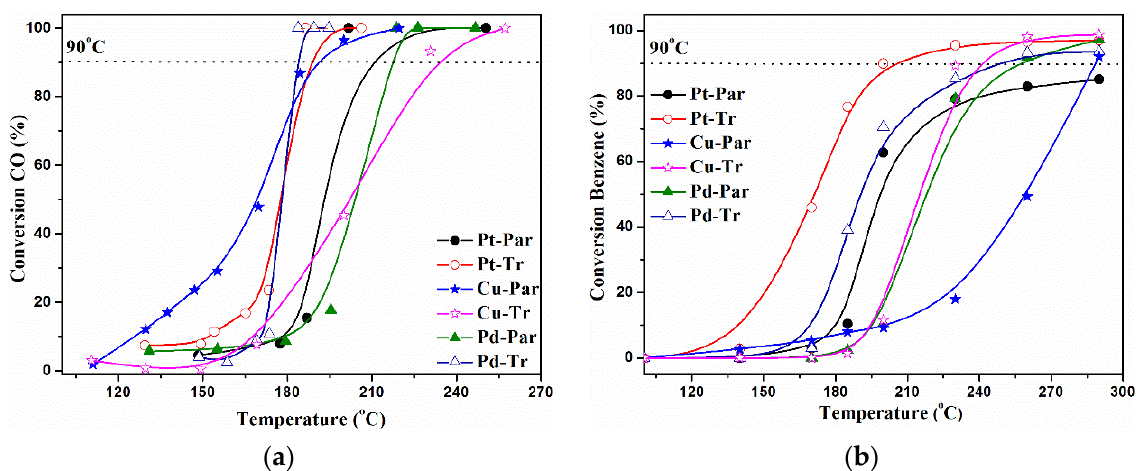
Figure 5. Temperature dependence of ( a ) carbon monoxide and ( b ) benzene conversion. Table 2. Catalytic activity in CO and benzene